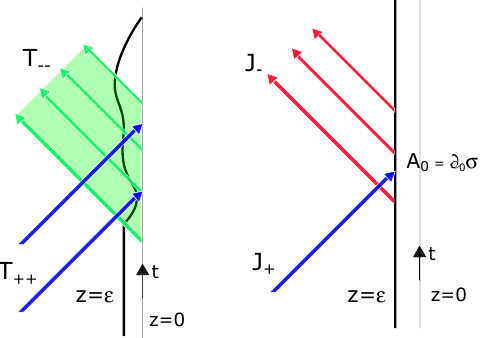
Figure 10 . Left: injecting energy in JT gravity leads to a preferred coordinate frame at each time, resulting in a (cid:13)uctuating boundary line. Right: injecting charge leads to a preferred gauge transformation at each